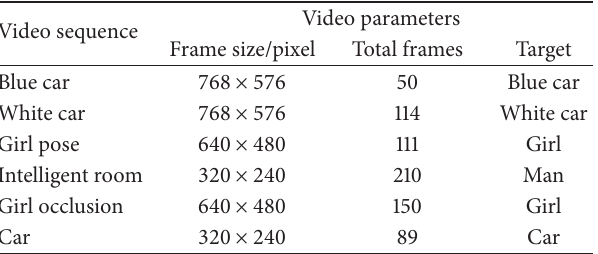
Table 3: Success rate